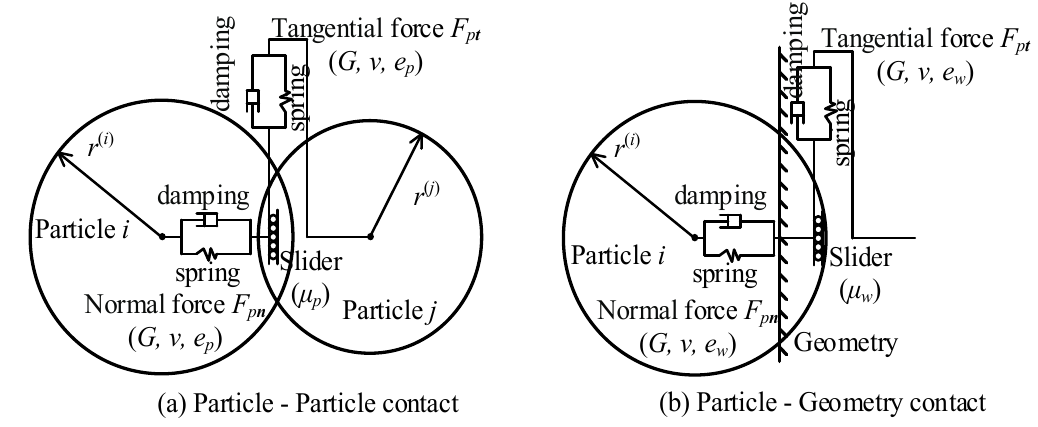
Figure 4. A damped Hertz-Mindlin contact